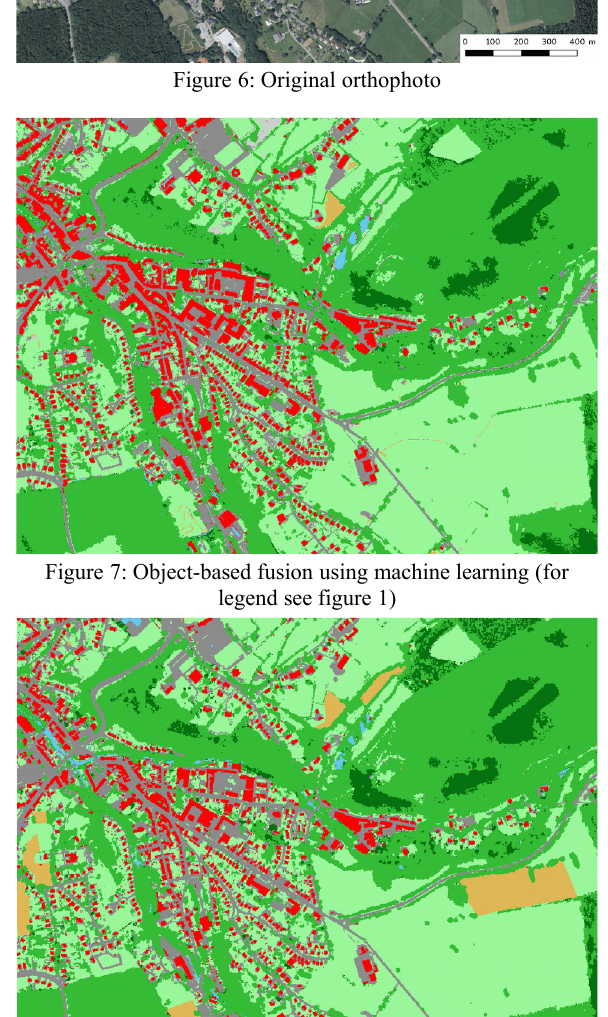
Figure 4: Illustration of over-segmentation in the OBIA approach